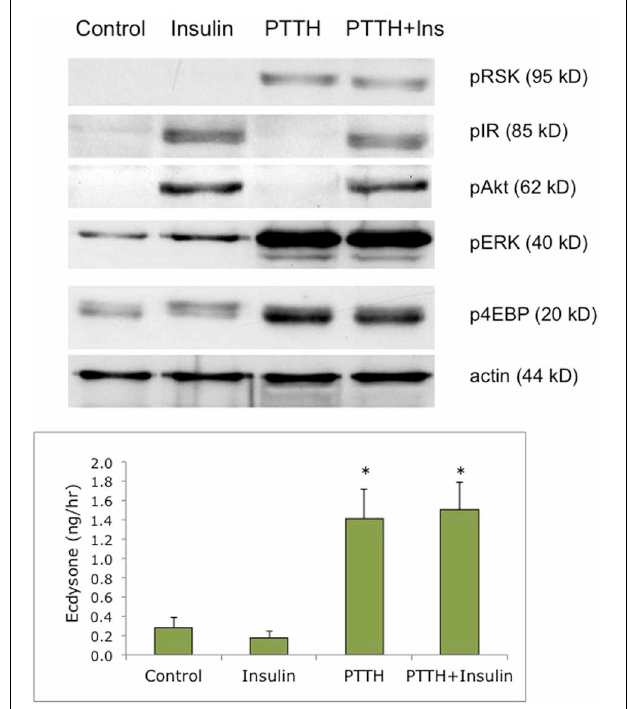
FIGURE 1 | Effects of PTTH and insulin on signaling phosphoproteins. Prothoracic glands from day 2 fifth instar larvae were incubated for 20min medium with or without insulin (6uM), followed by 80min in one of the following treatments: no hormone (Control), insulin (6uM), PTTH (7nM), or insulin + PTTH. (TOP) Western blots of cellular lysates, probed for phosphoproteins; (BOTTOM) Ecdysone secretion determined by radioimmunoassay of culture medium at the end of the 80 incubation period. Asterisks denote statistically significant ecdysone secretion relative to no-hormone controls ( n = 5 glands per group). Insulin did not enhance secretion, alone or in conjunction with PTTH (ANOVA, Tukey–Kramer post-hoc test, significance p > 0.05).